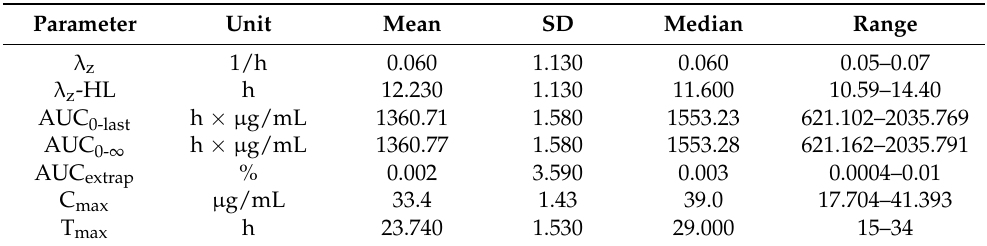
Table 2. Geometric mean milk pharmacokinetic parameters of meloxicam following single oral administration at the dose rate of 30 mg/kg in lactating dairy cows ( n =